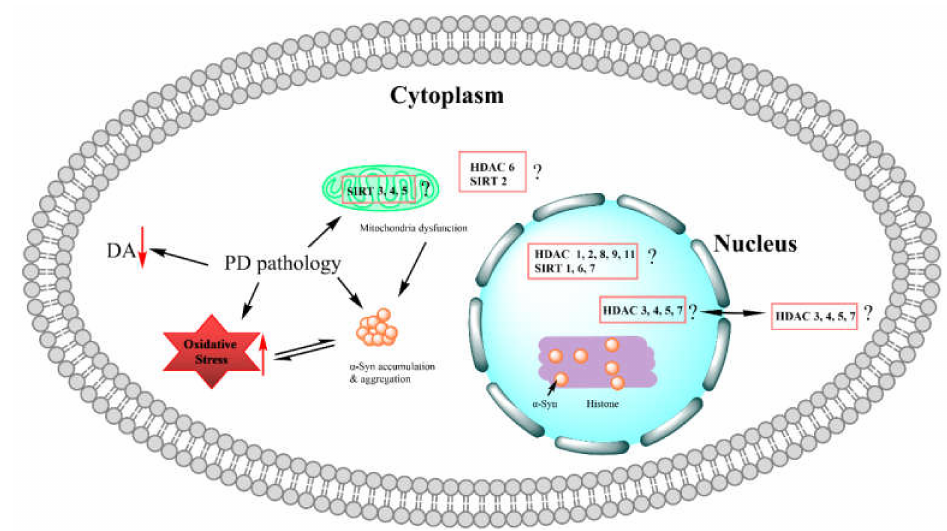
Figure 1. PD pathology and localizations of histone deacetylases. Current knowledge about the PD pathology mainly includes dopamine (DA) decrease, α -synuclein aggregation, oxidative stress, and mitochondrial dysfunction; whether histone deacetylases are linked with this pathogenesis in PD still remains to be explored and illustrated. This leaves a question mark for every histone